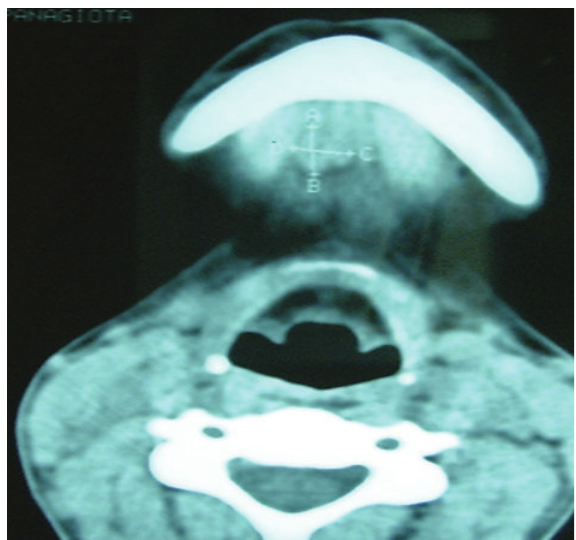
Figure 3: The computed tomography (CT) of the submental area showing a semitransparent cystic formation with distinct boundaries.